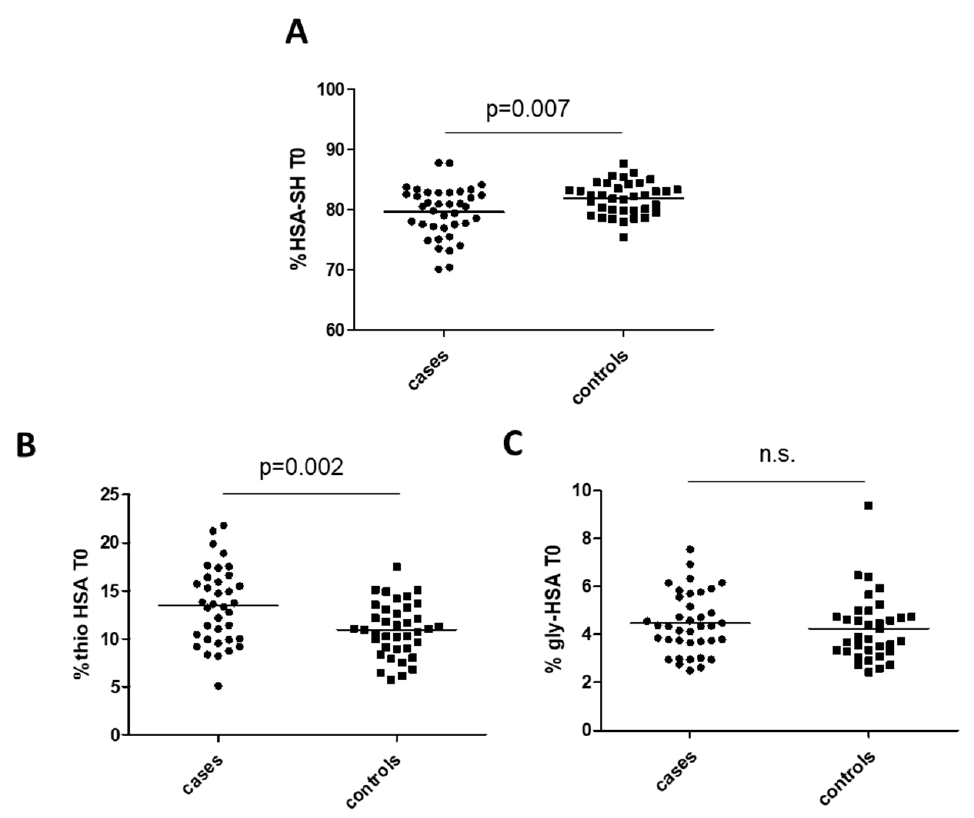
Figure 2. Albumin isoforms in cases and controls: ( A ) mercaptoalbumin (HSA-SH), ( B ) thiolated albumin (Thio-HSA), and ( C ) glycated albumin (Gly-HSA). p -Values are from Student’s t -test. n.s. means not significant.